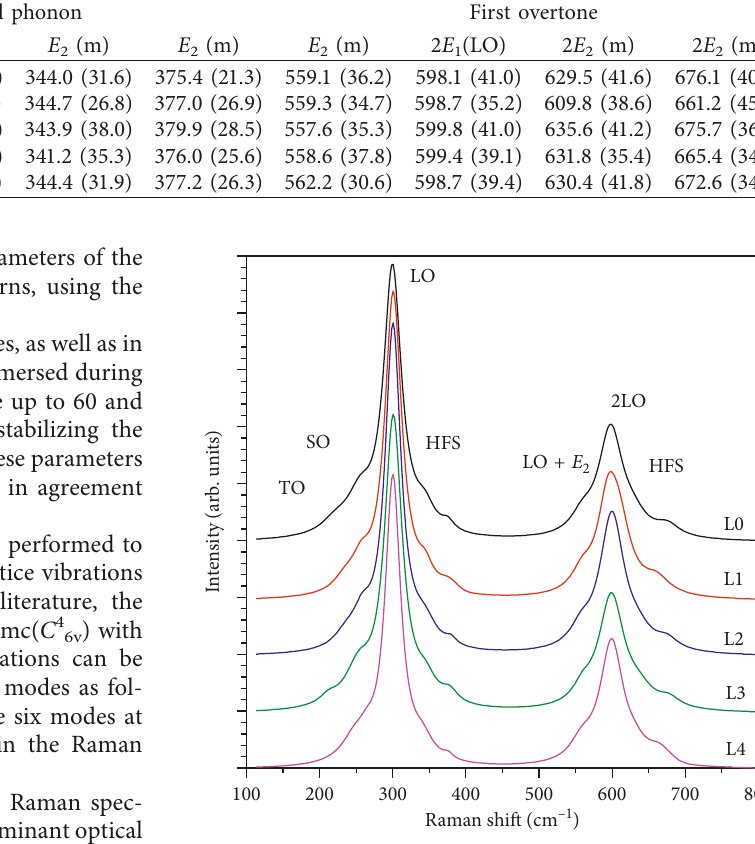
Figure 3: Raman spectra set obtained for the CdS:Cu films ob- tained by ionic exchange process in aqueous